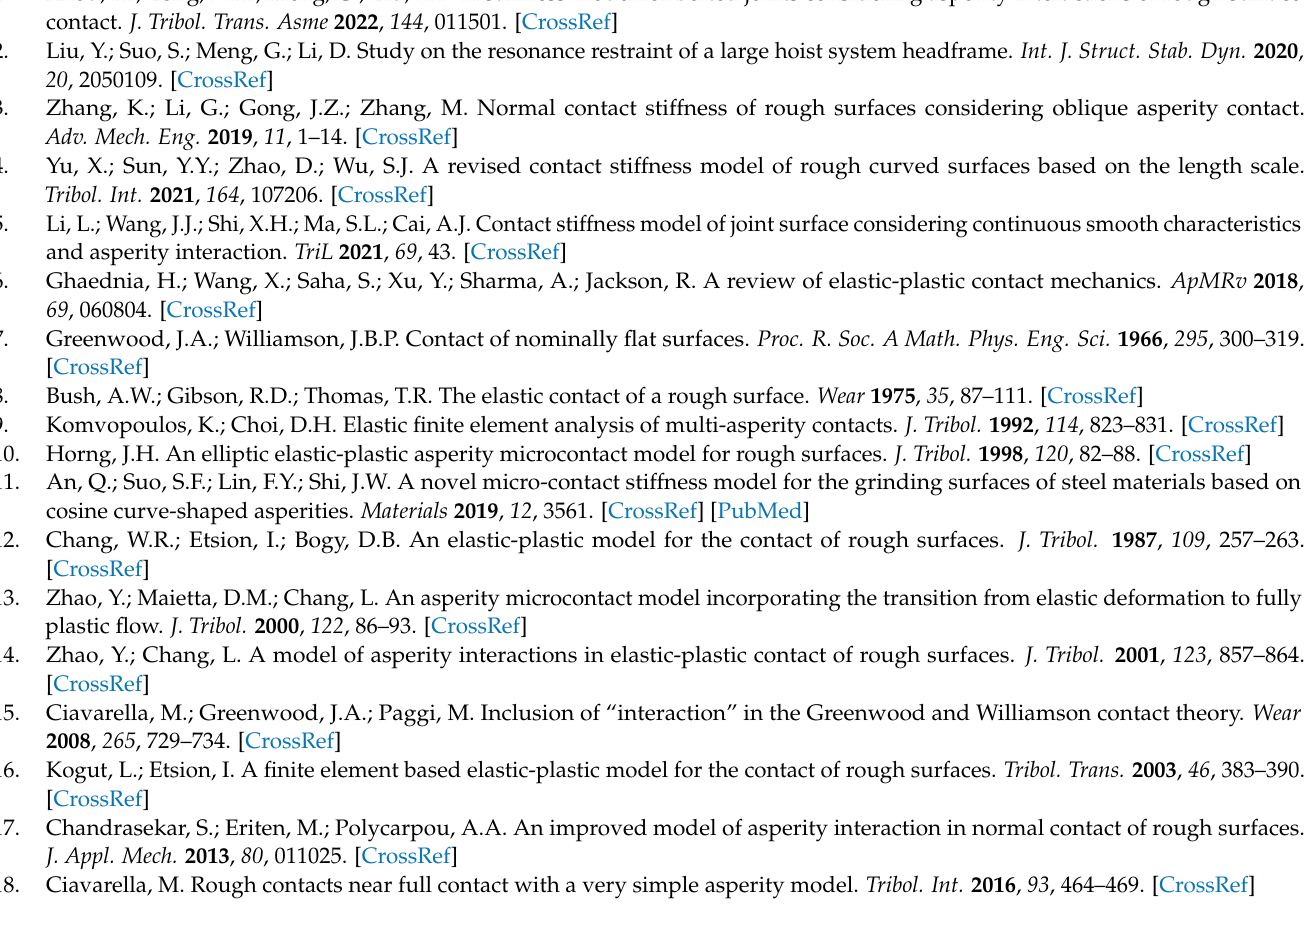
Figure S2: (a) A schematic diagram of the contact stiffness test rig, (b) Physical drawings of the contact stiffness test rig; Table S1: Comparison results of normal contact stiffness under different methods; Table S2: Comparison results of normal contact stiffness—different arc radii of turning tools; Table S3: Comparison results of normal contact stiffness—different turning feed rates; Table S4: Comparison results of normal contact stiffness—different grinding depths; Table S5: Comparison results of normal contact stiffness—different fractal dimensions; Table S6: Comparison results of normal contact stiffness—different scale